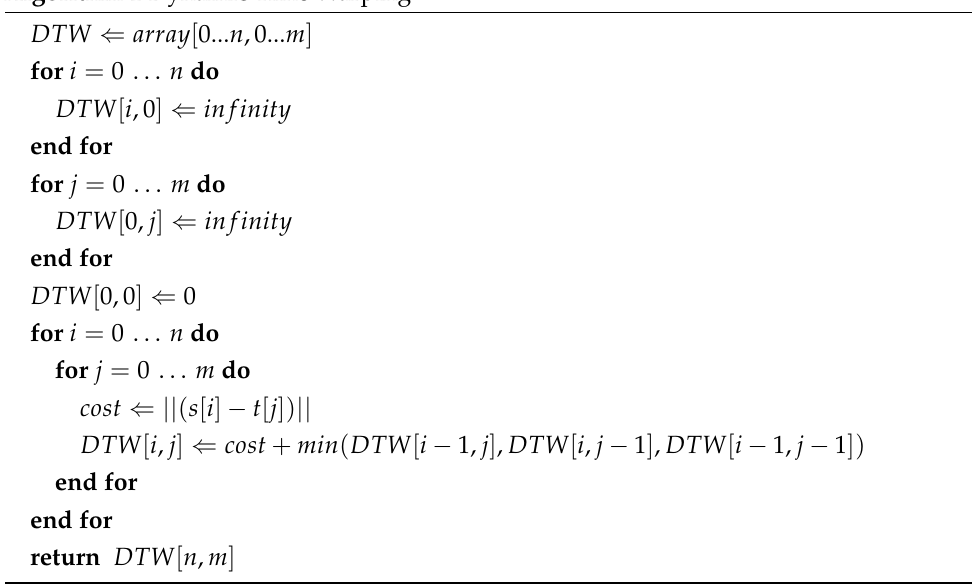
Algorithm 1 Dynamic Time